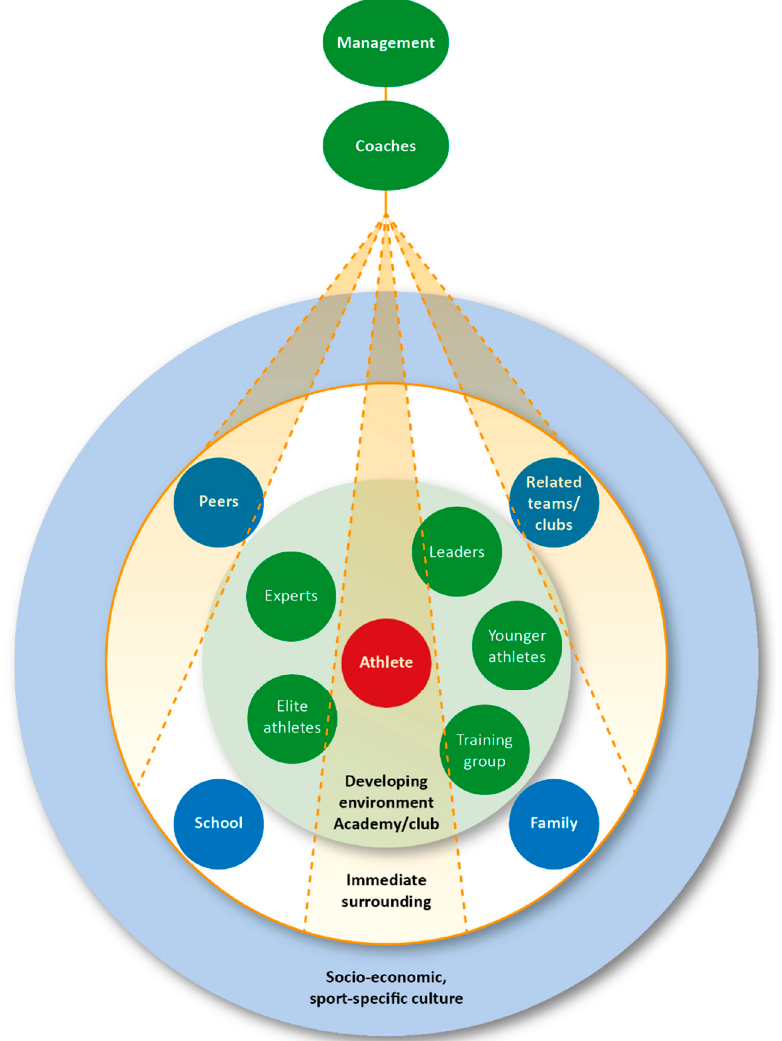
Figure 2. The “UPF” model ([36], p. 60).